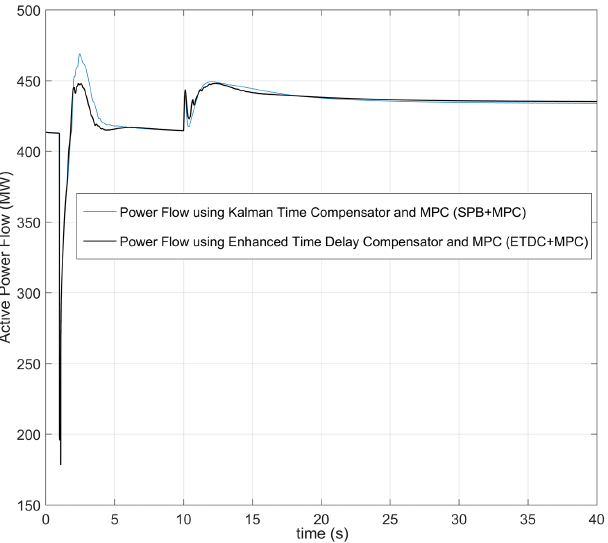
Figure 9. Comparative performance using SPB + MPC and the enhanced ETDC + MPC.